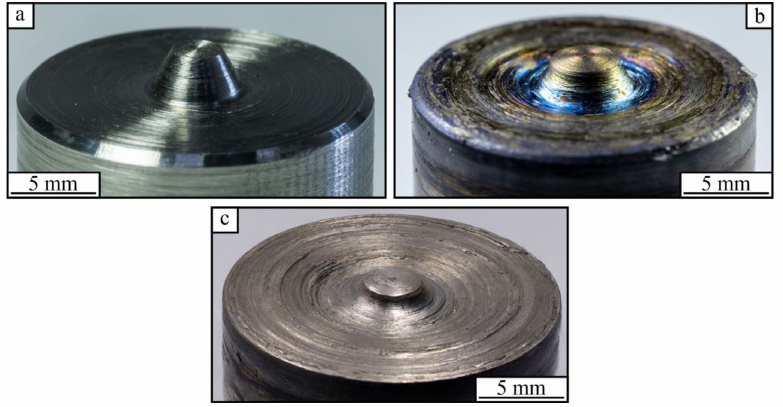
Figure 16. FSW tool produced from alloy ZhS6U before welding ( a ), after ≈ 2 m of welding ( b ), and after ≈ 2 m of welding without water cooling ( c ).